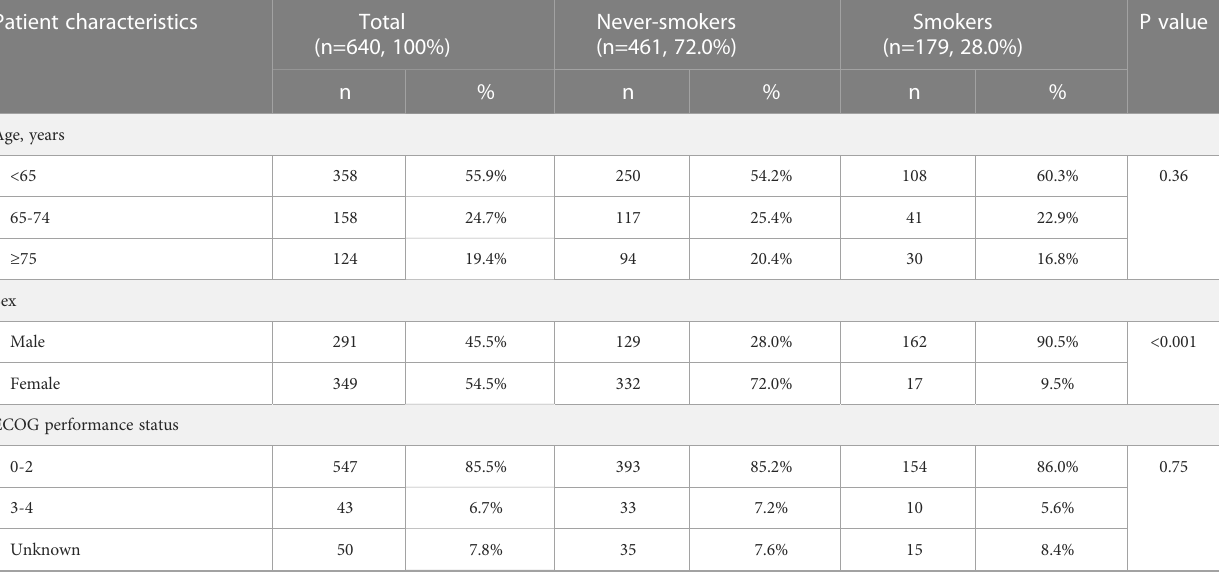
TABLE 2 Characteristics of the patients with known smoking